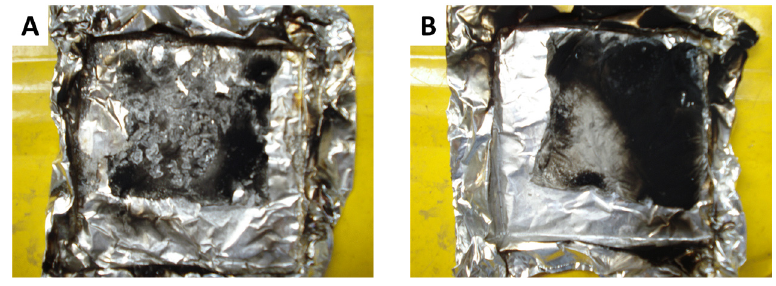
Figure 15. Residues at the end of the cone calorimeter test. ( A ) LDPE coated with 5A40 coating. ( B ) ( B ) LDPE coated with 5A20 coating. LDPE coated with 5A20 coating.